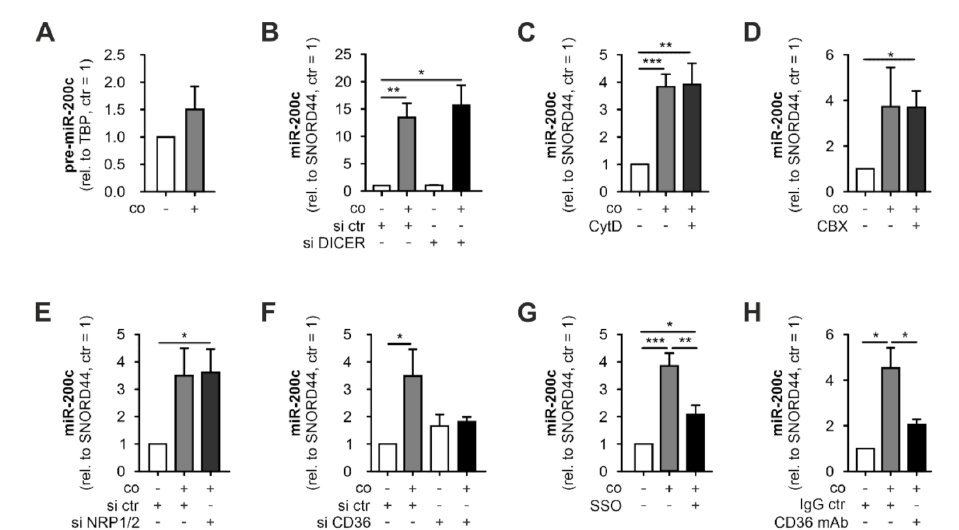
Figure 2. miR-200c is transferred from MCF7 cells to primary human M Φ . Primary human macrophages (M Φ ) were cocultured with MCF7 cells before (pre-) miR-200c levels in M Φ were determined. ( A ) M Φ pre-miR-200c levels after coculture (48 h) with MCF7 cells. M Φ miR-200c levels upon ( B ) DICER knockdown, ( C ) cytochalasin D (CytD) treatment (10 µ M), ( D ) carbenoxolone (CBX) treatment (100 µ M), ( E ) neuropilin receptor (NRP) 1/2 knockdown, ( F ) CD36 receptor knockdown, ( G ) CD36 inhibitor sulfo-N-succinimidyl oleate (SSO) treatment (5 µ M), or ( H ) neutralizing CD36 antibody treatment (2 µ g/mL). (Pre-) miRNA levels were determined using qPCR and normal- ized to either SNORD44 or TBP (pre-miRNA). ( B , E , F ) Knockdown was achieved by transfection with specific siRNAs 24 h prior to coculture. Data are depicted as mean ± SEM ( n ≥ 5; * p < 0.05, ** p < 0.01, *** p <